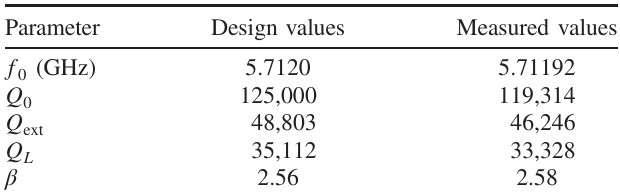
TABLE II. Comparison between the design and the measured cavity parameters of the DAA structure on axis coupled with a waveguide input coupler.